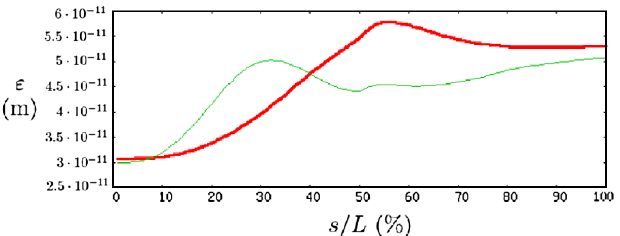
FIG. 9. (Color) Top: Approximate longitudinal beam potential for the Cornell ERL. Bottom: A section of the ERL illustrating the approximation of the beam’s potential (thick dark red) by a round-beam model (thin light